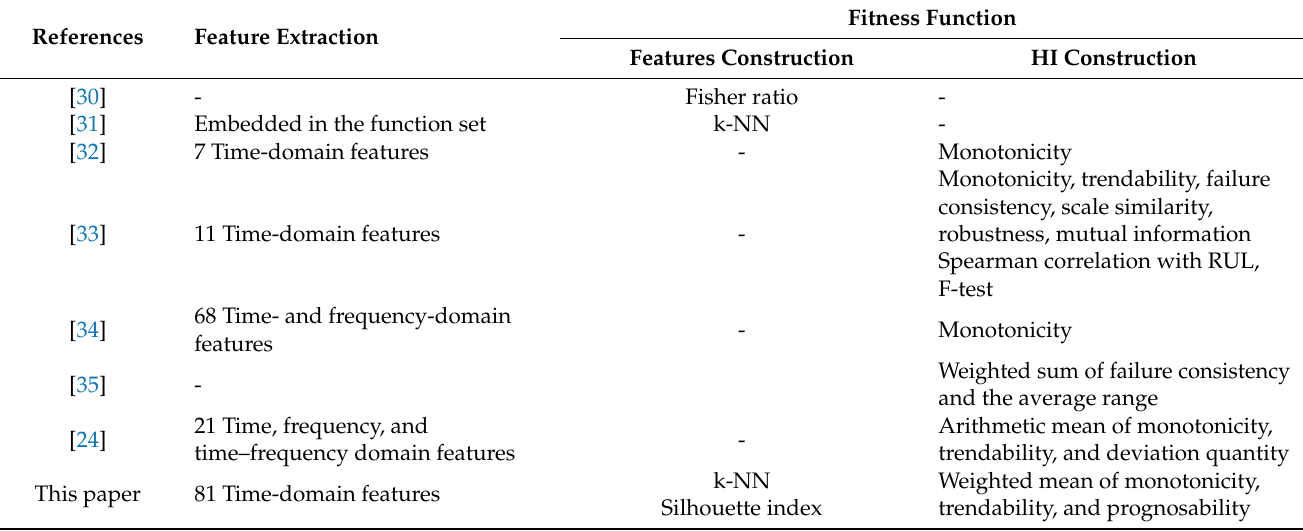
Table 2. Similarities and differences between the proposed approach and other